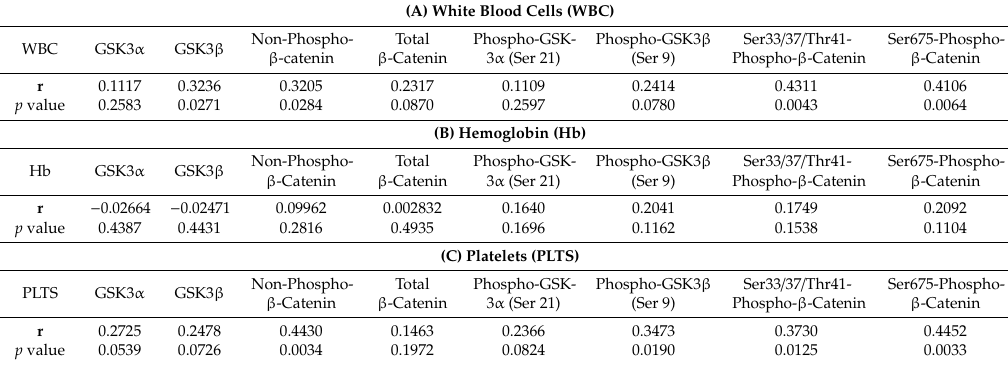
Table 2. Correlation between hemogram and Wnt signaling expression in AML blast cells. Spearman analysis was used to assess the correlation between Wnt protein levels in blast cells and parameters of the hemogram, including ( A ) white blood cells (WBC); ( B ) Hemoglobin (Hb), and ( C ) platelets (PLTS). Statistical significance when p ≤